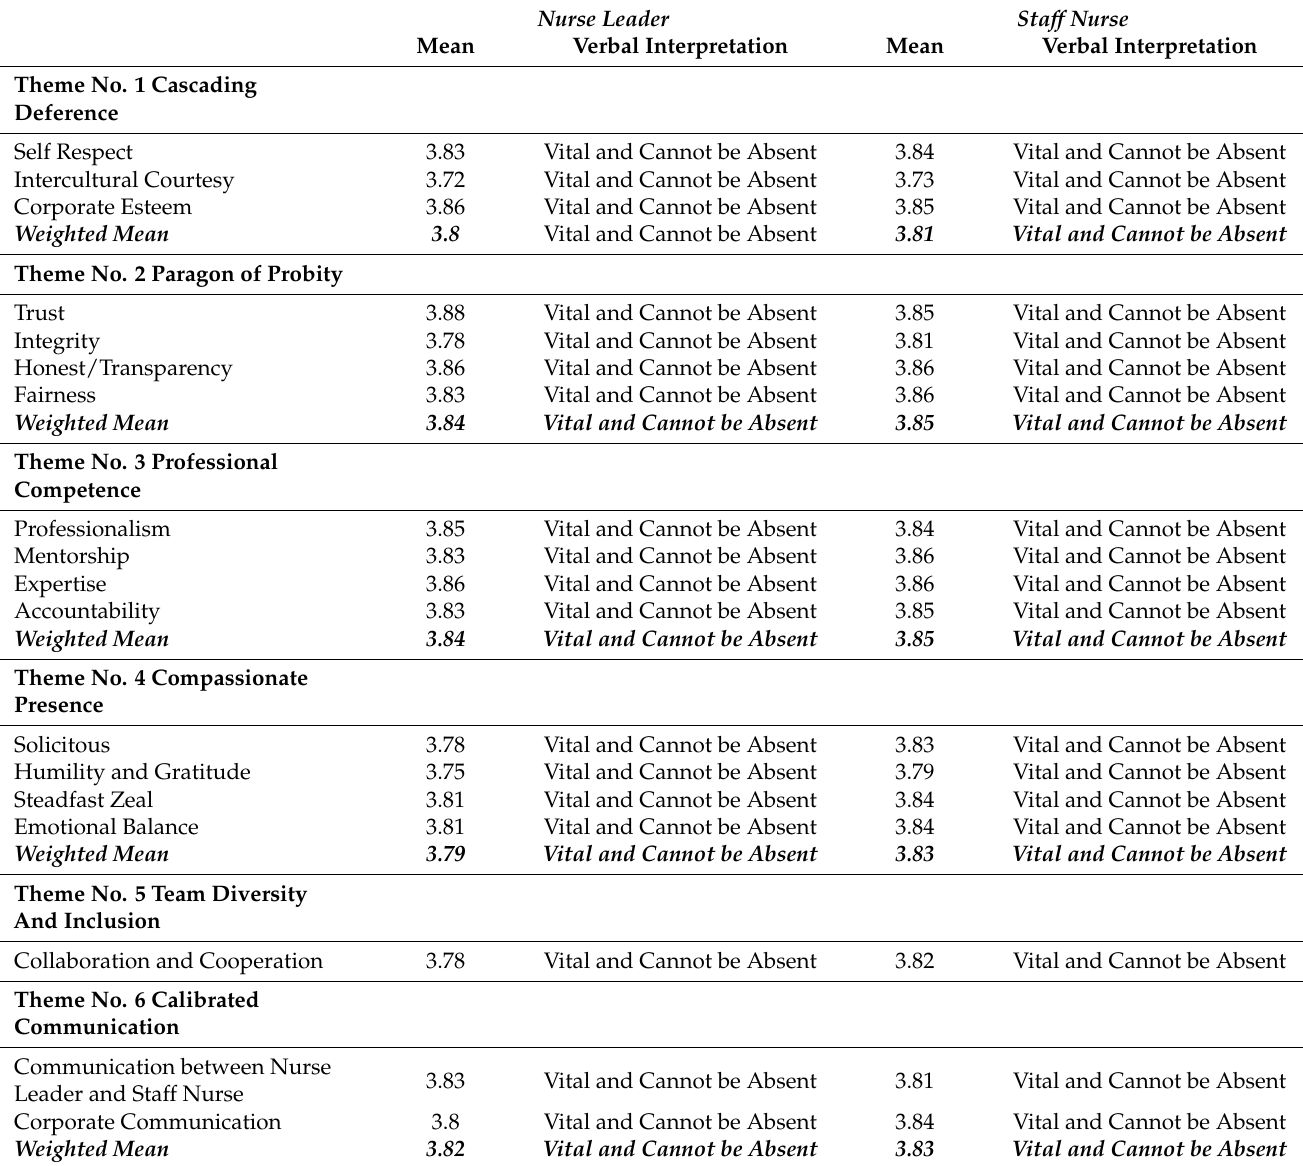
Table 4. Weighted mean distribution of effective values of nurse leaders perceived as vital by nurse leaders and staff nurses ( n =